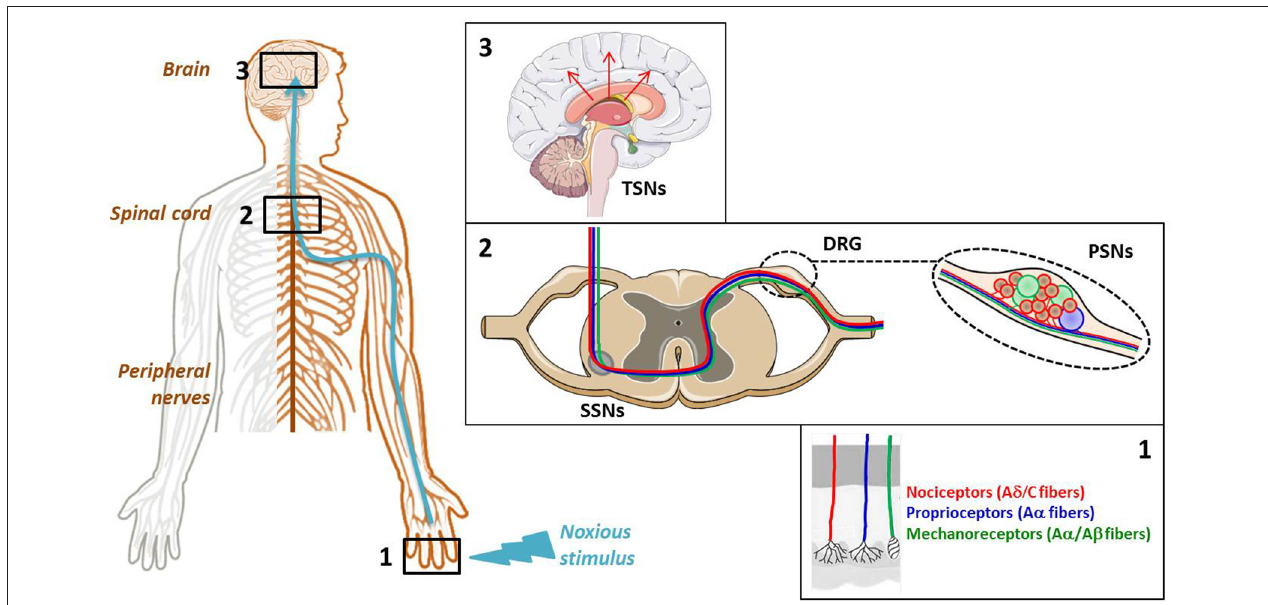
FIGURE 1 | Cellular elements involved in pain transmission from the peripheral to the central nervous system (CNS). (Box 1) The pain (thermal, high pressure, mechanical, chemical) information is first detected by the receptors located at the level of free nerve endings of primary sensory neuron (PSN) fibers. (Box 2) Then, it is conveyed by the dendrites of these neurons, components of dorsal root ganglia (DRG), to the dorsal horn of spinal cord where it is transmitted to the dendrites of secondary sensory neurons (SSNs). (Box 3) Finally, it is brought to the hypothalamus via the tertiary sensory neurons (TSNs) whose cell bodies constitute, in part, the brain